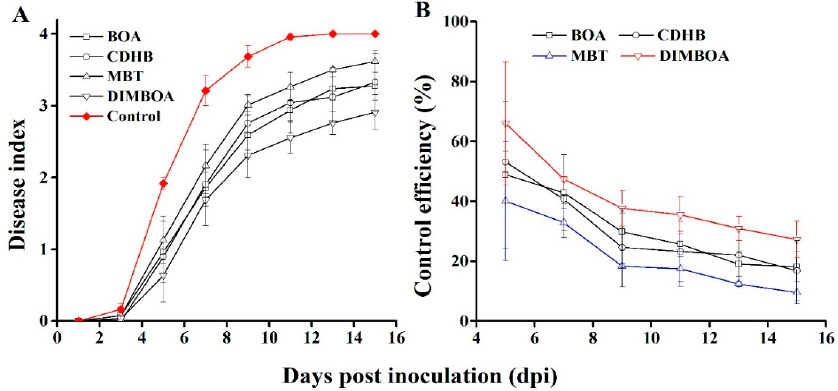
Figure 6. The disease index ( A ) and control efficiency (B ) of DIMBOA and its derivatives on seedlings inoculated with R. solanacearum . The 10-mL solution of DIMBOA and its derivatives (10 mg/L) and DMSO (0.05%) were respectively irrigated into tobacco roots, then 10 mL of freshly cultured suspension of R. solanacearum (1 × 10 8 CFU/mL) was inoculated to the rhizosphere of each 4-week-old tobacco plants which were treated with DIMBOA and its derivatives after 24 h. Symptoms were rated daily using a disease index scale of 0–4 (0, no symptoms appeared; 1, 1%–25% of leaves wilted; 2, 26%–50% of leaves wilted; 3, 51%–75% of leaves wilted; 4, 76%–100% of leaves wilted). Each point represents the average disease index of 20 plants. The DIMBOA and its derivatives treatment was significantly different from the DMSO treatment ( p < 0.05; repeated-measures ANOVA). Similar results were observed in two other independent